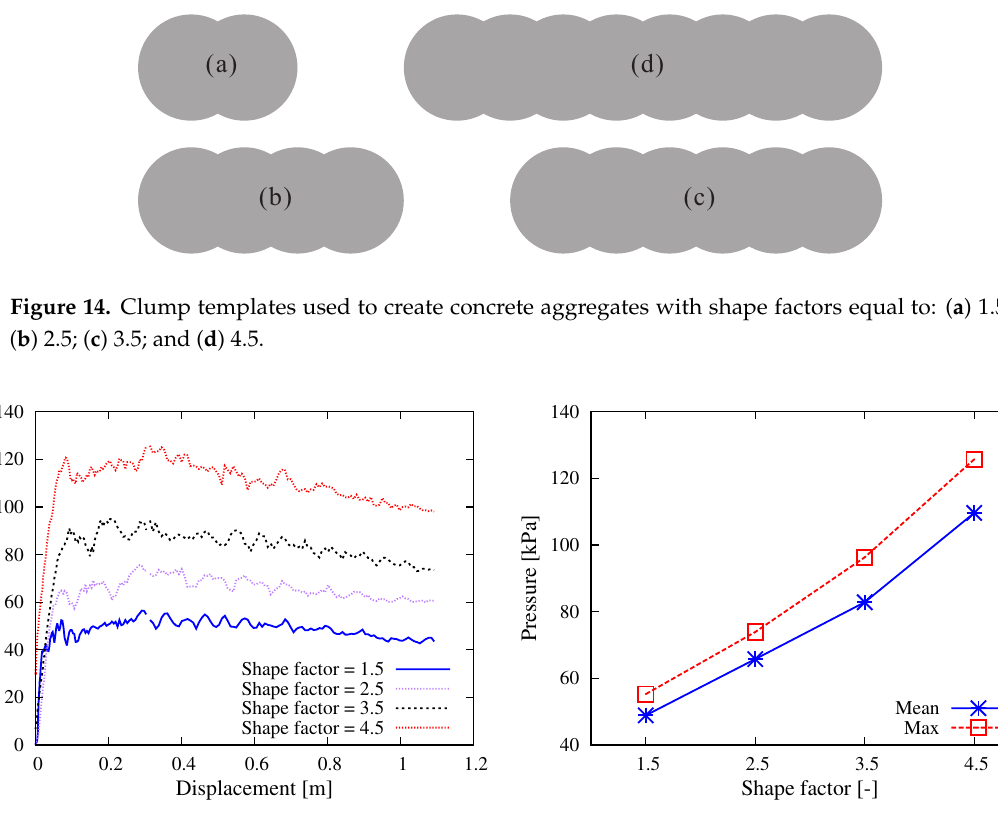
Figure 15. Simulation results with respect to the aggregate shape: ( left ) curves of the thrusting pressure vs. displacement relationship; and ( right ) mean and max values during the stable pumping